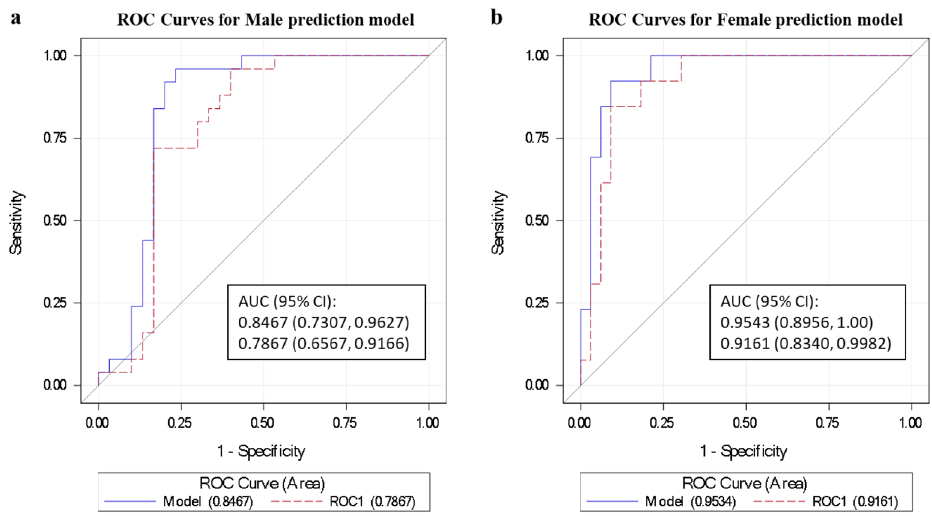
Figure 4. Evaluating subclinical atherosclerosis multivariable logistic regression models classifier output quality using cross-validation in male prediction model ( a ) and female prediction model ( b ). Model ROC curve in blue and cross-validated ROC curve in red, with respective AUC and 95% confidence intervals shown. CI, Confidence interval; AUC, area under